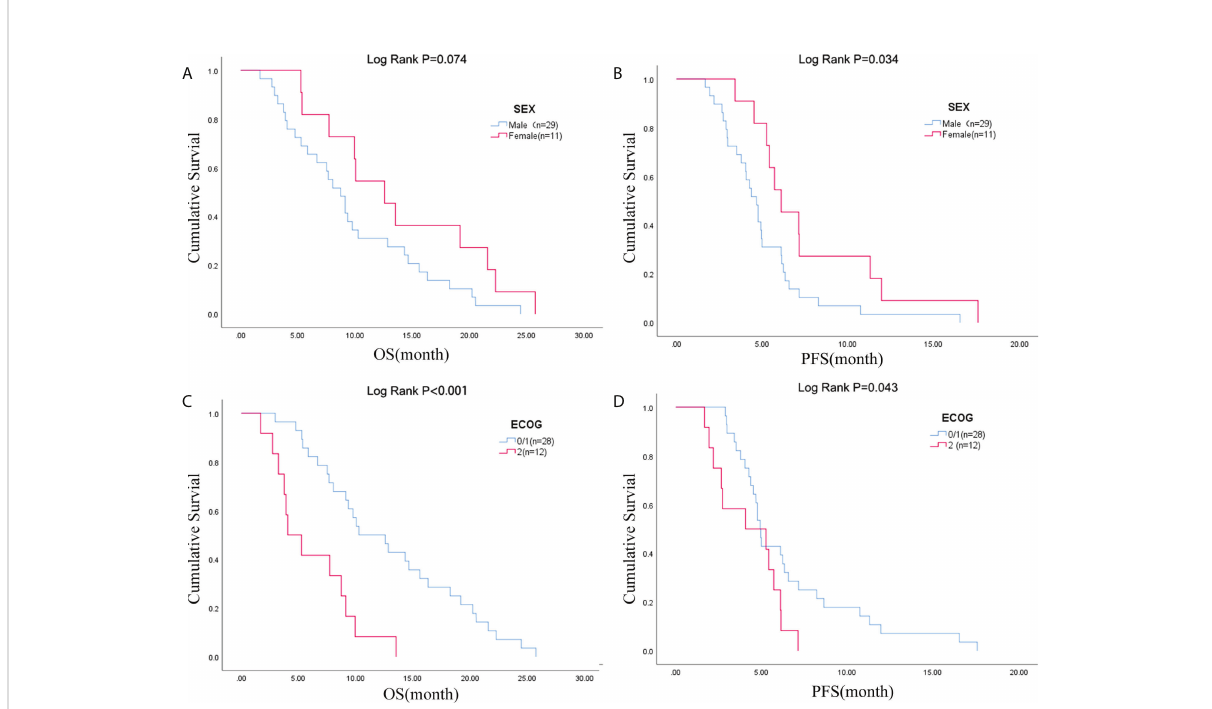
Figure 4D). In addition, we performed Cox regression analysis, summarized in Table 3. Cox hazard proportion model